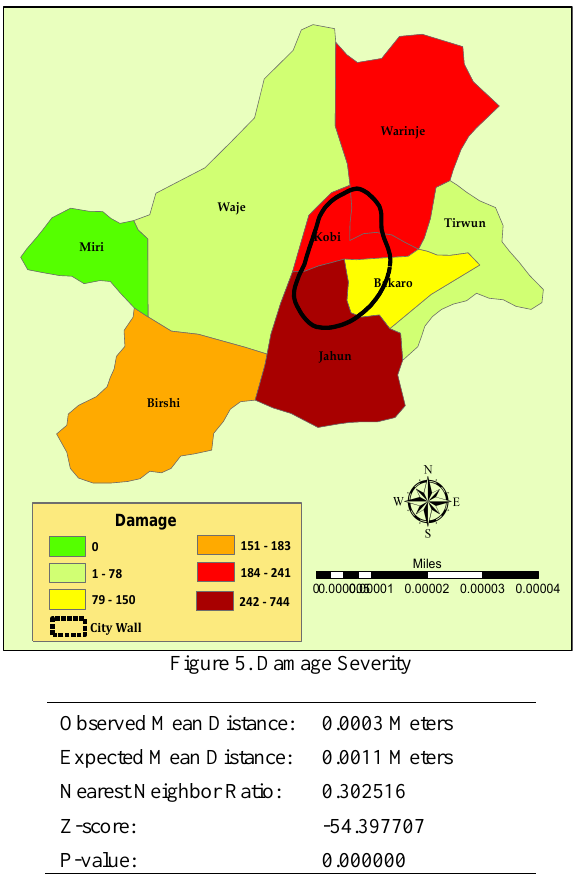
Table 1. Average Nearest Neighbor summary